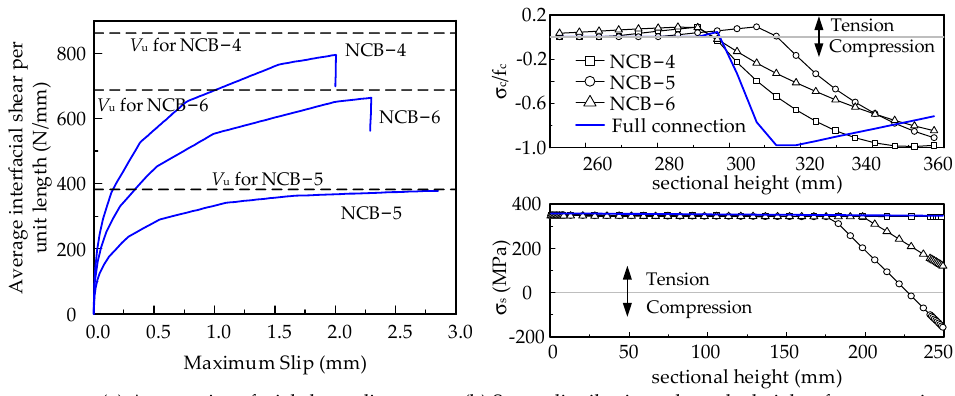
(b) Stress distributions along the height of cross-section(a) Average interfacial shear-slip curves